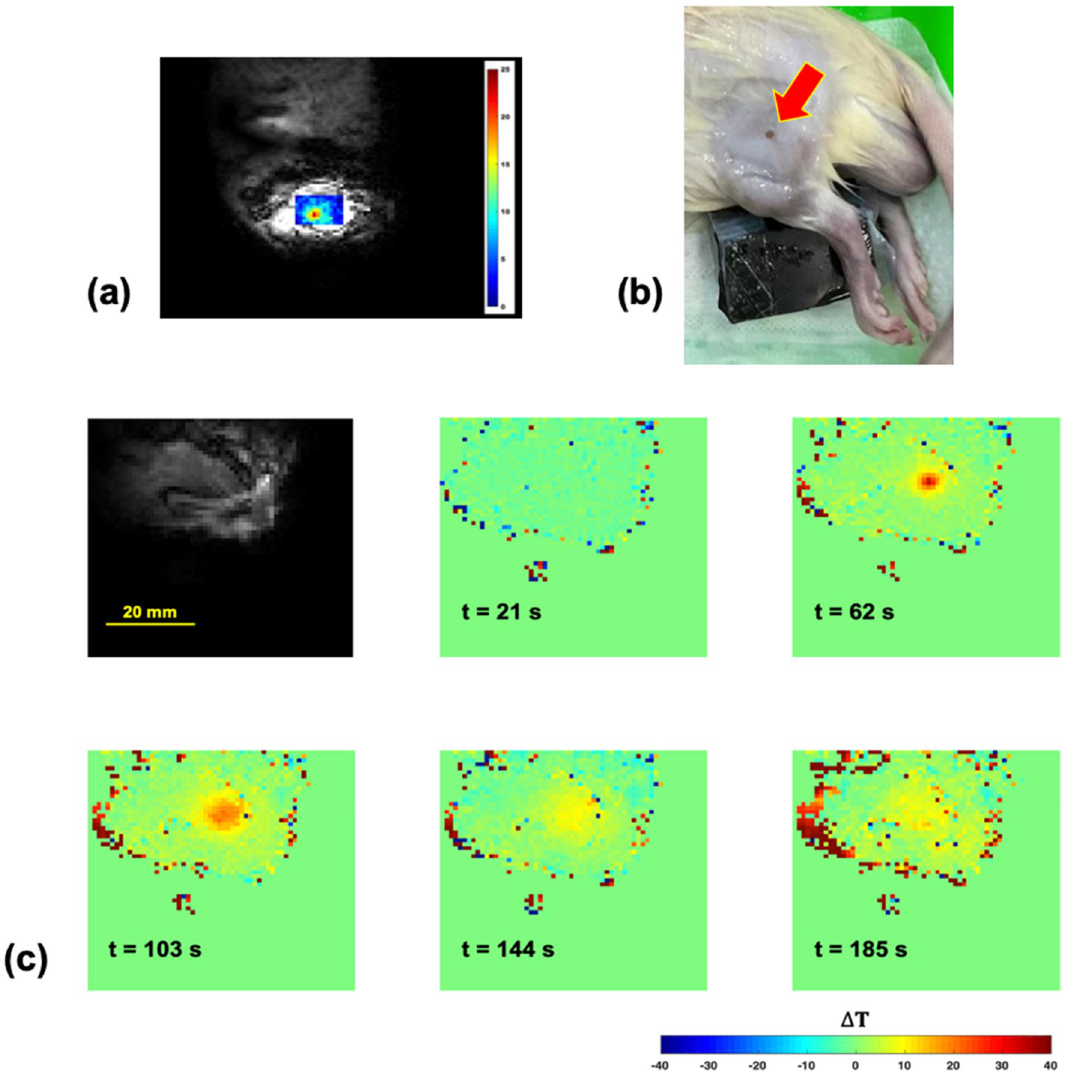
Figure 8. ( a ) Superimposed image of temperature map and coronal-view of the rat hind thigh at t = 82 s. ( b ) Photograph of the rat hind thigh after HIFU ablation. Red arrow indicates the lesion. ( c ) The representative magnitude image (upper left) and temperature maps obtained from ex vivo rat experiments at t = 21 s, 62 s, 103 s, 144 s and 185